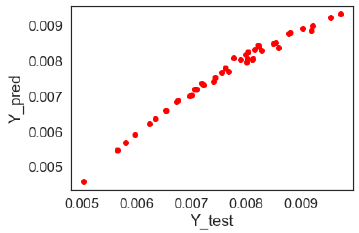
Figure 6. Fouling factor prediction of shell and tube heat ex- changer